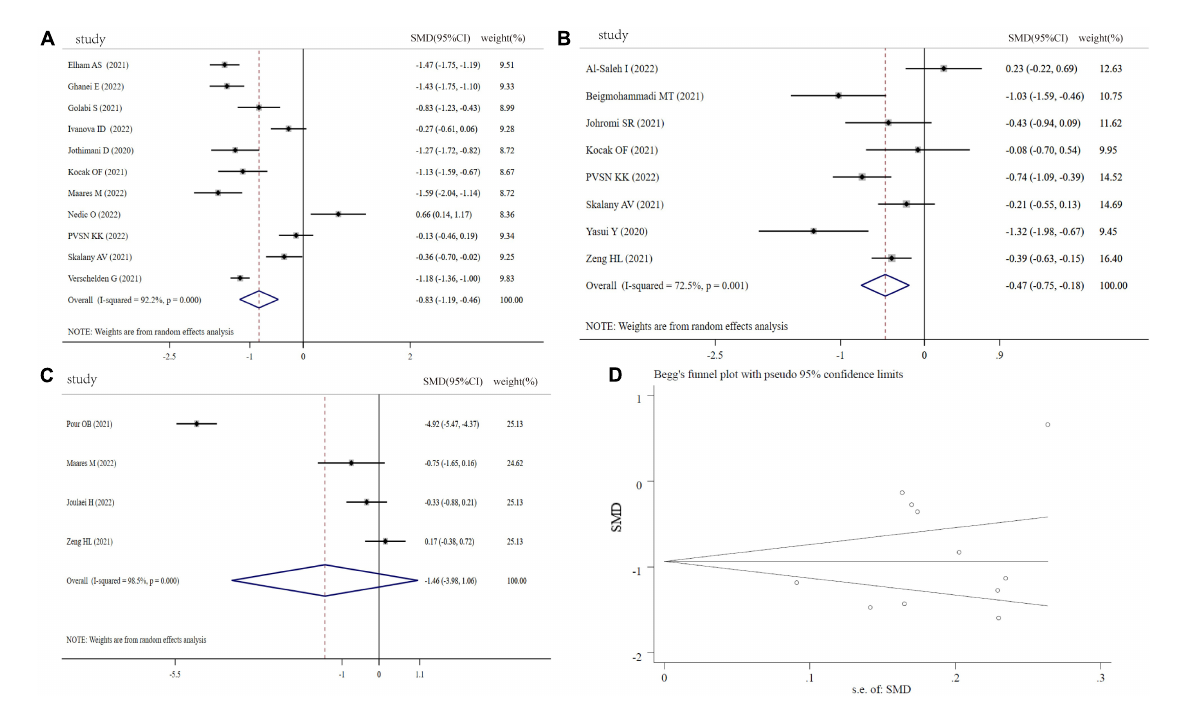
FIGURE2 Forest plot of Zn levels. (A) Zn levels between COVID-19 patients and controls; (B) Zn levels between severity status and non-severity status in COVID-19 patients; (C) Zn levels between non-survivors and survivors in COVID-19 patients; (D) funnel plot of the meta-analysis on Zn levels between COVID-19 patients and